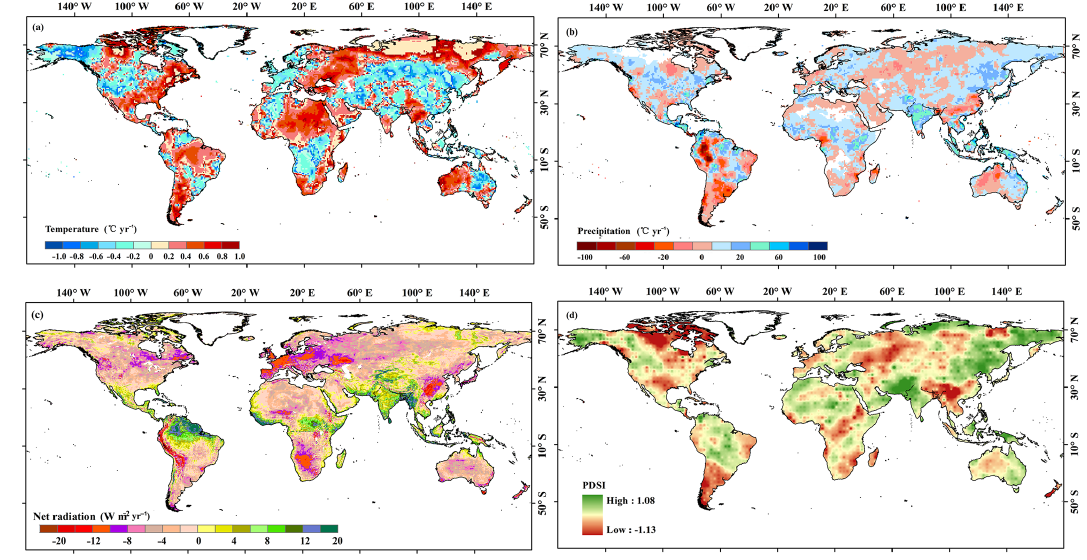
Figure 2. Trends of air temperature ( T ), precipitation ( P ), net radiation ( R n ), and Palmer Drought Severity Index (PDSI) from 2000 to 2014.